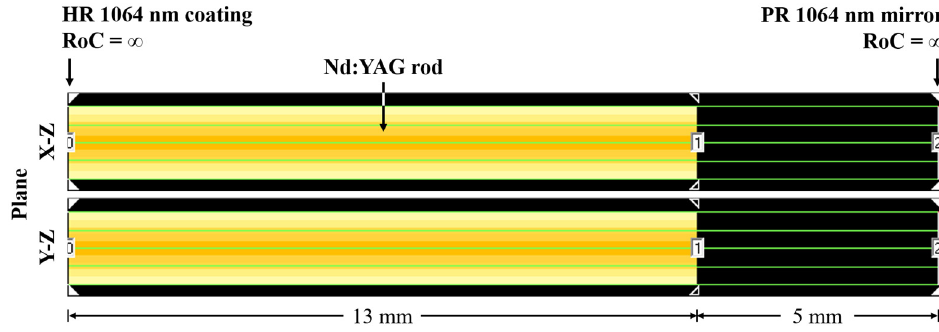
Figure 5. Laser resonator design in LASCAD ™ for one 4.00 mm diameter, 13 mm length Nd:YAG rod. RoC is the radius of curvature.